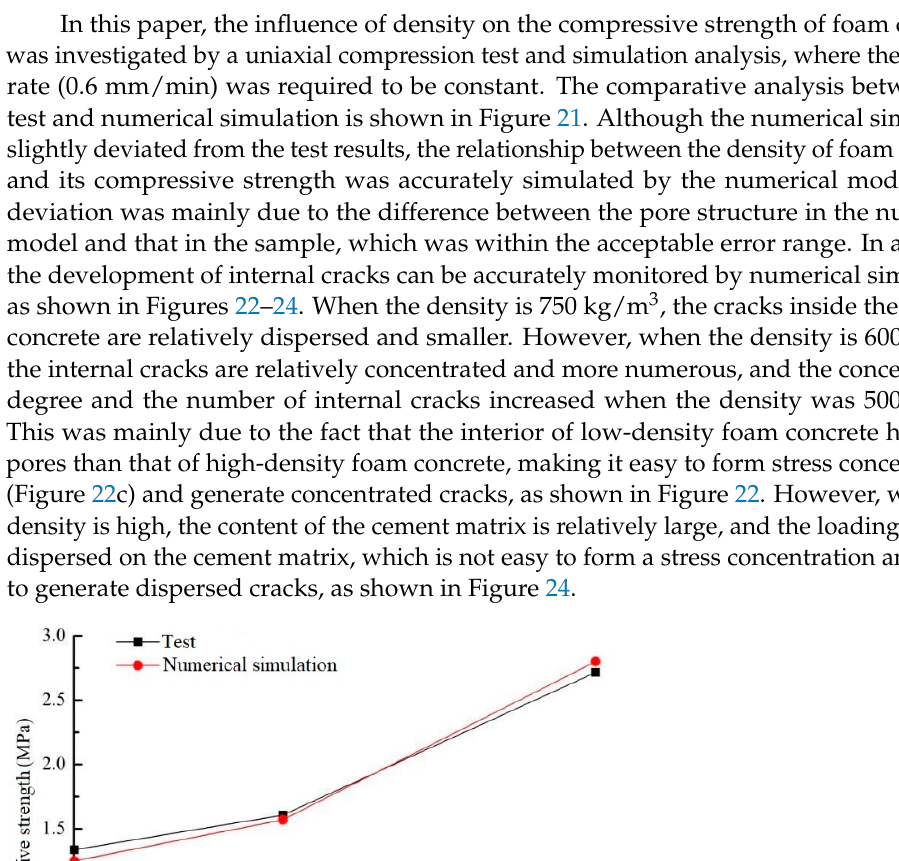
Figure 20. The calculation model for uniaxial compression of cube specimens.